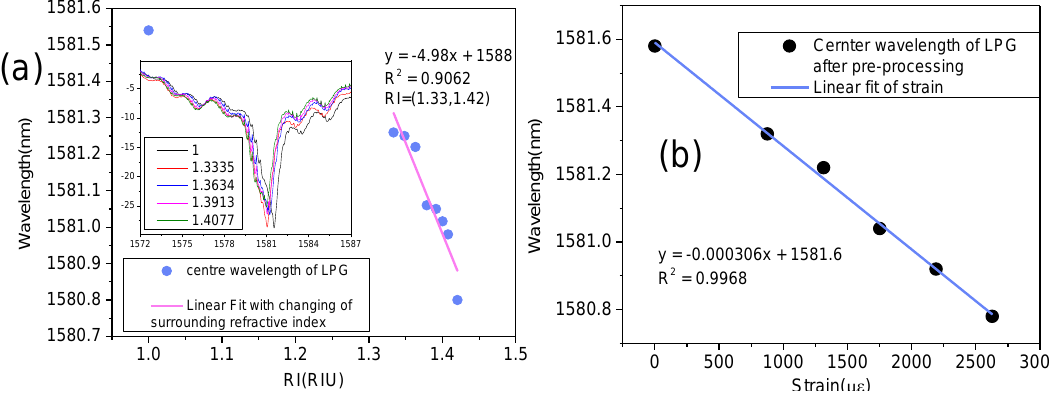
Figure 5. The LPFG’s sensitivity of ( a ) the environment refractive index; and ( b ) strain.